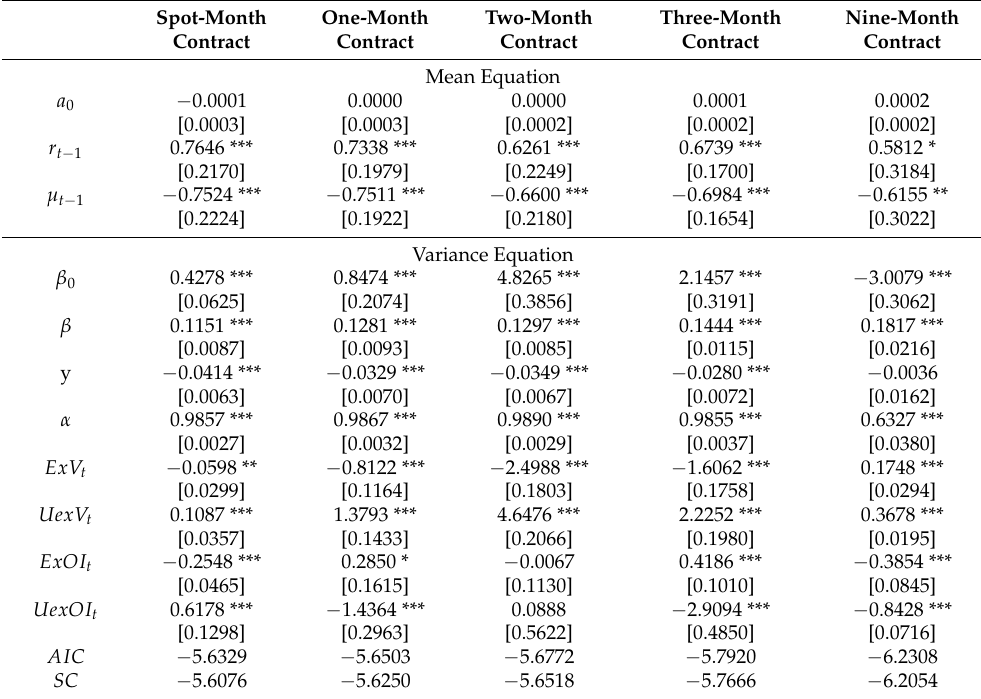
Table 5. Estimation Results of EGARCH (1,1) for Malaysian Crude Palm Oil